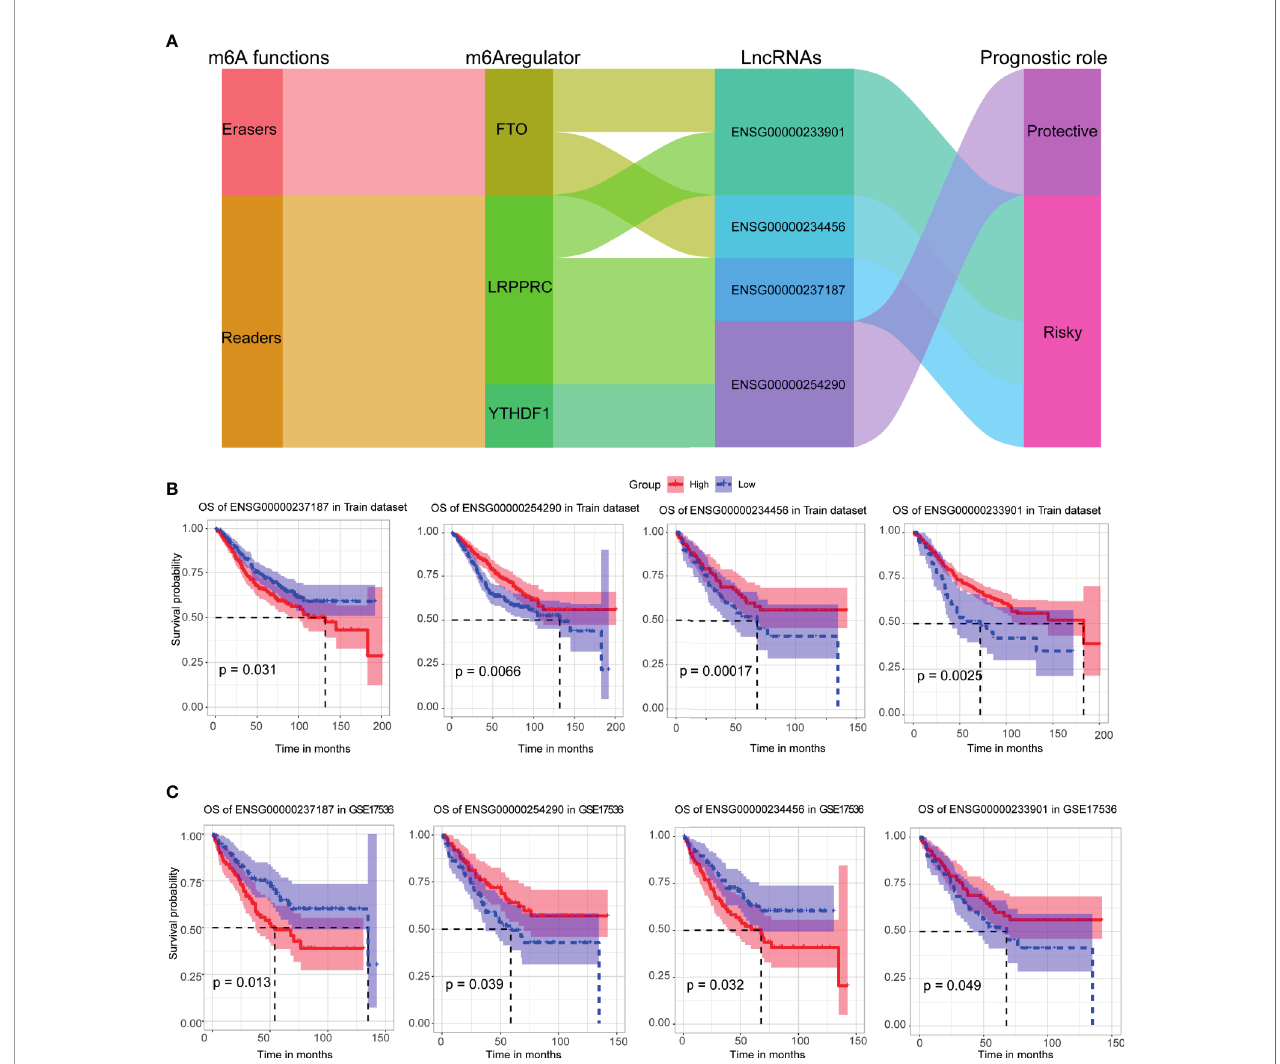
FIGURE 4 | Survival analysis of four crucial lncRNAs. (A) The alluvial plot showed the roles of these four lncRNAs in CC. (B) Kaplan – Meier curves showed the four lncRNAs ’ survival ef fi cacy in GSE39582 data set. (C) Kaplan – Meier curves showed the four lncRNAs ’ survival ef fi cacy in GSE17536 data